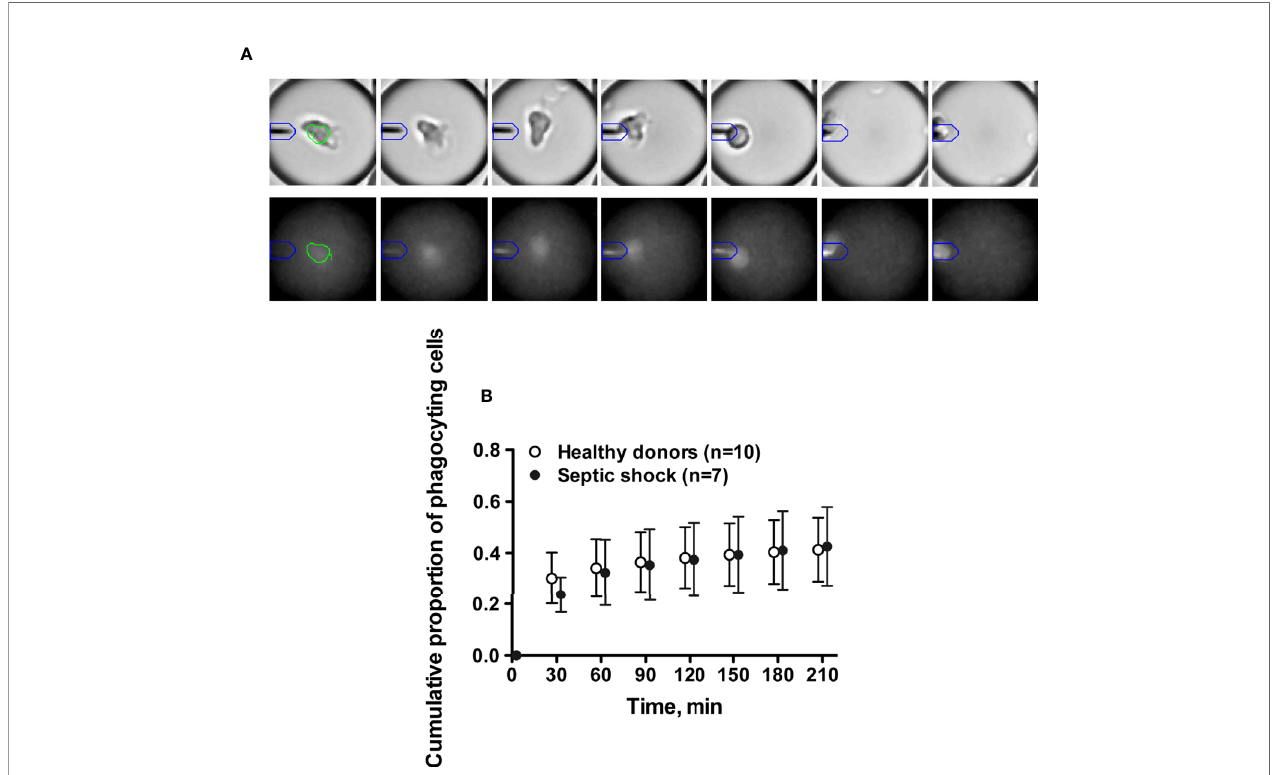
FIGURE 3 | Single cell dynamic micro fl uidic monitoring of monocyte phagocytosis. (A) Kinetics of phagocytosis activity of one monocyte starting at 90 min. Bright fi eld images (upper panel) illustrate cell migration toward the beadline (from center to the left of the droplet). Fluorescence images (lower panel) show the impact of phagocytosis on the beadline fl uorescence signal (fuzzy fl uorescence signal at 180 min due to the loss of beadline integrity). (B) Cumulative proportions of monocytes with phagocytosis of magnetic beadline over 180 min after LPS